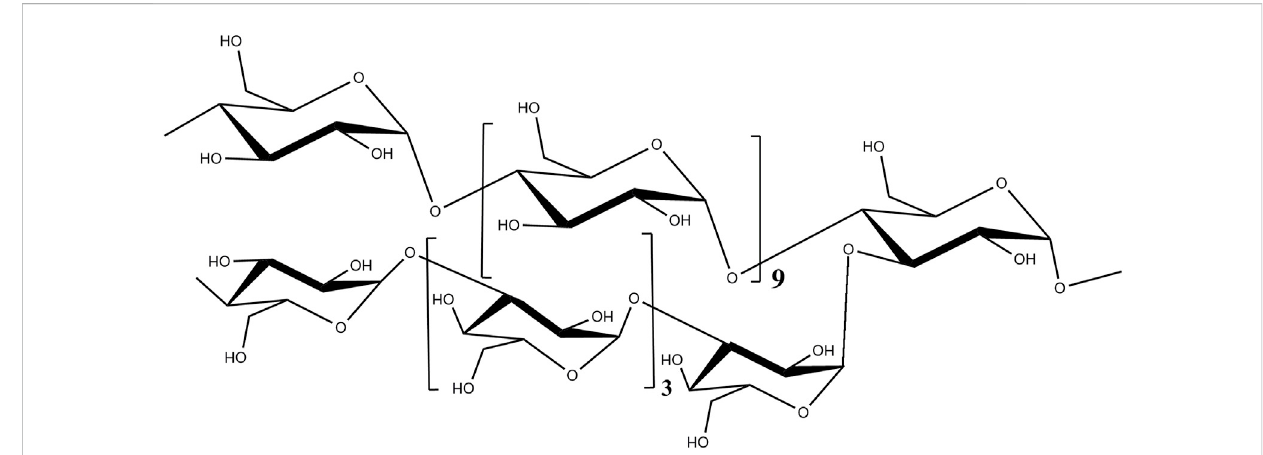
FIGURE 1 Chemical structure of